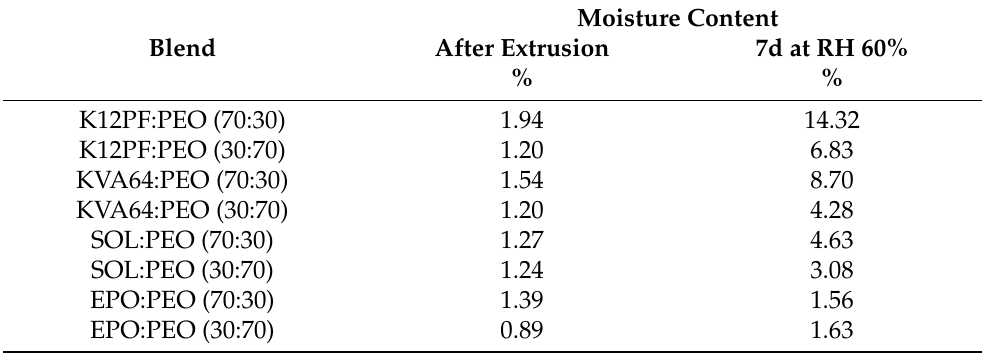
Table 3. Moisture content of filaments directly after extrusion and after storage in a 60% RH environment for 7